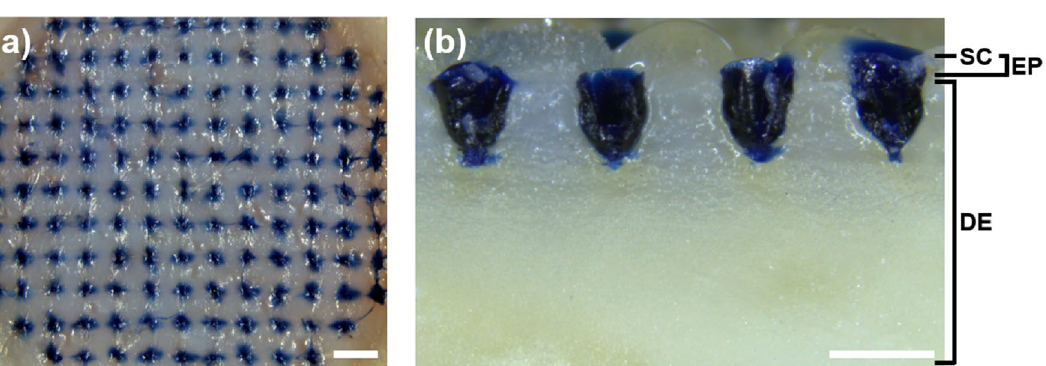
Figure 3. ( a ) Optical image of the porcine skin surface after administration and removal of trypan blue microneedles (Scale bar = 1 mm). ( b ) Optical image of a cross-section of the microneedles passing through the blue dots (Scale bar = 500 μm). ‘SC’, ‘EP’, and ‘DE’ refer to stratum corneum, epidermis, and dermis, which are components of the skin layer, respectively. Trypan blue containing the vaccine was transferred to the epidermis and dermis of the